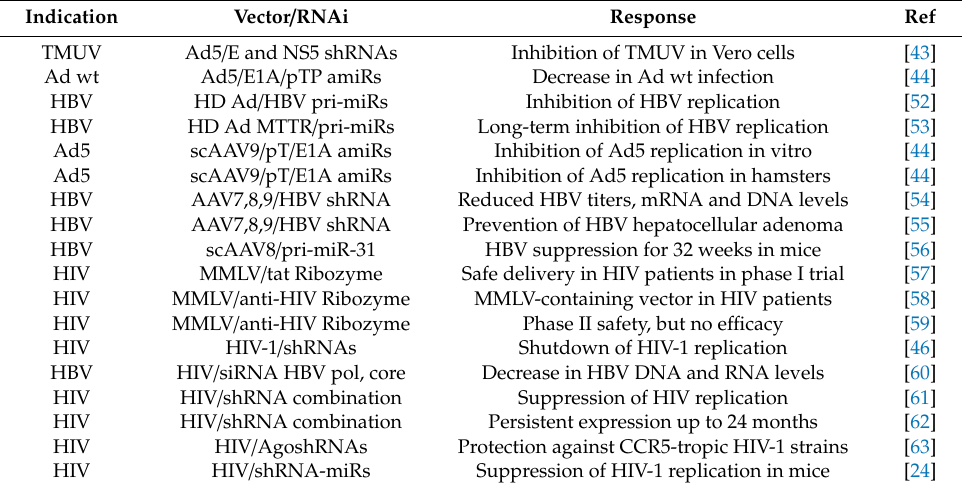
Table 1. Examples of RNAi-based antiviral therapy using viral